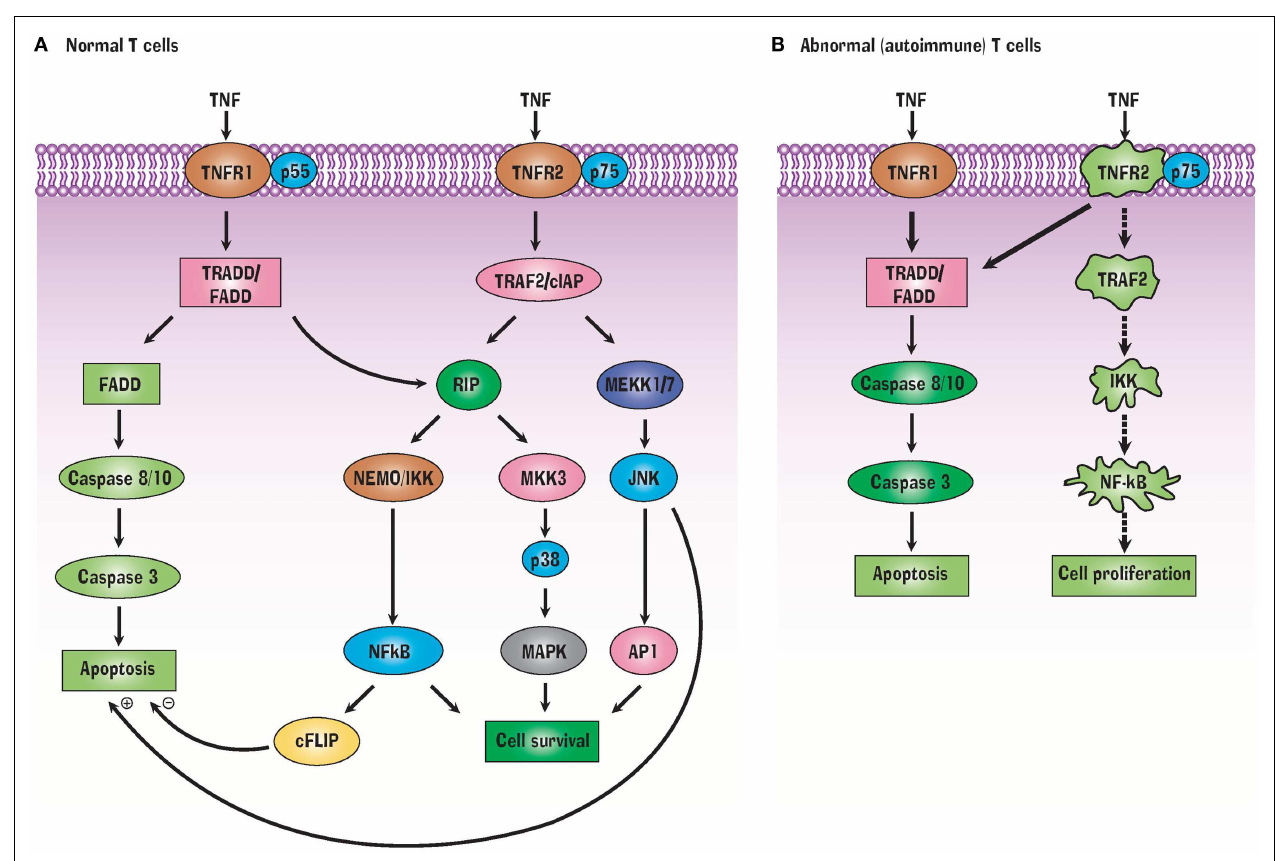
FIGURE 1 |TNF Signals through TNFR1 and TNFR2 receptors (A) but abnormalities in this signaling pathway in autoimmunity (B) can favor a pathway of selective apoptosis due to a variety of protein signaling defects